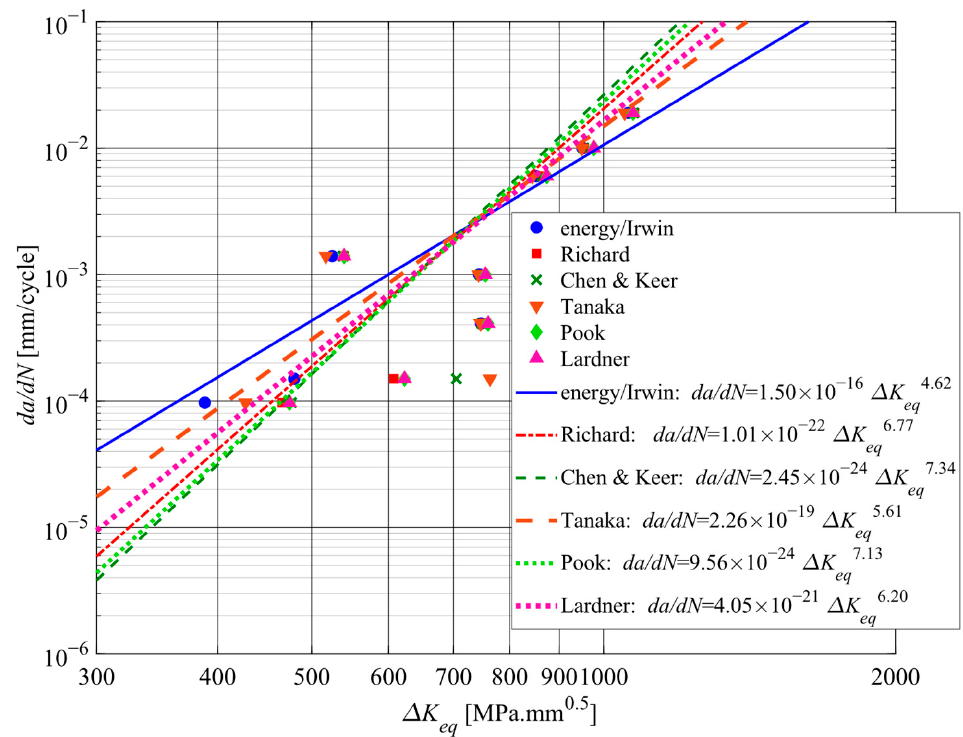
Figure 6. da / dN vs. ∆ K eq using different definitions of K eq .